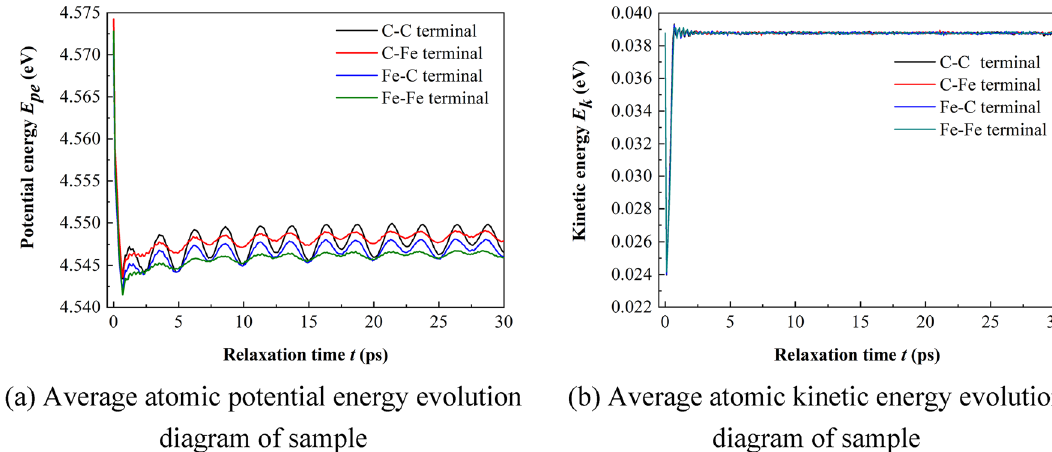
Figure 8. Evolution of energy with relaxation time